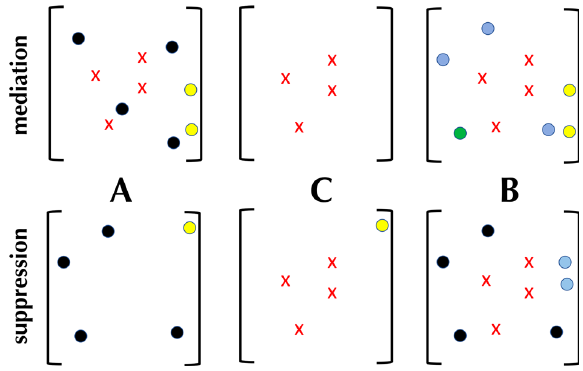
Fig. 2 Adjacency matrices cartoons displaying mediation and suppression. Pictorical representations of triplets of adjacency matrices, where only the position of the edges (ones in the matrix) are highlighted as symbols (dots of different colours, crosses). Symbols are chosen to schematically highlight how mediation and suppression operate. In the top row, network C is mediating the relation between networks A and B (Algorithm 2) and as such most of those edges which are common to A and B are due to the fact that both networks A and B share these edges with network C . In the bottom row, network C acts as a suppressor between A and B (Algorithm 3). Edges which are common to A and C are suppressed in B (yellow dots), and otherwise A and C synergistically interact and B inherits edges which are present in one but not the other network (black dots and red